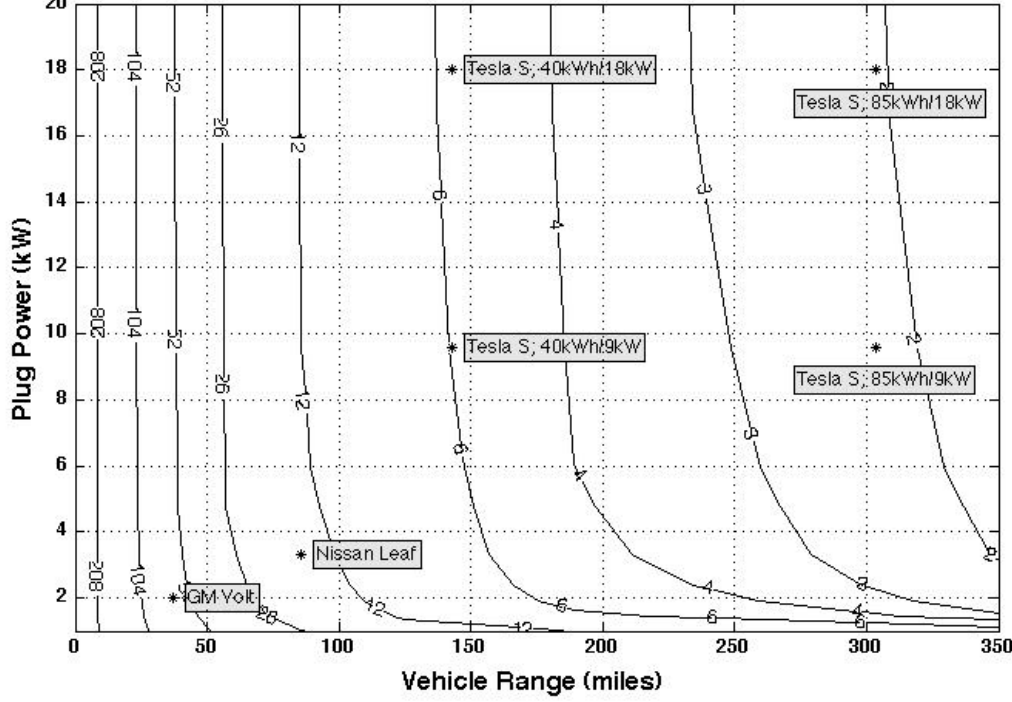
Figure 7. Adaptation days for vehicles that charge at all stops . Reprinted by permission, from Pearre [24].